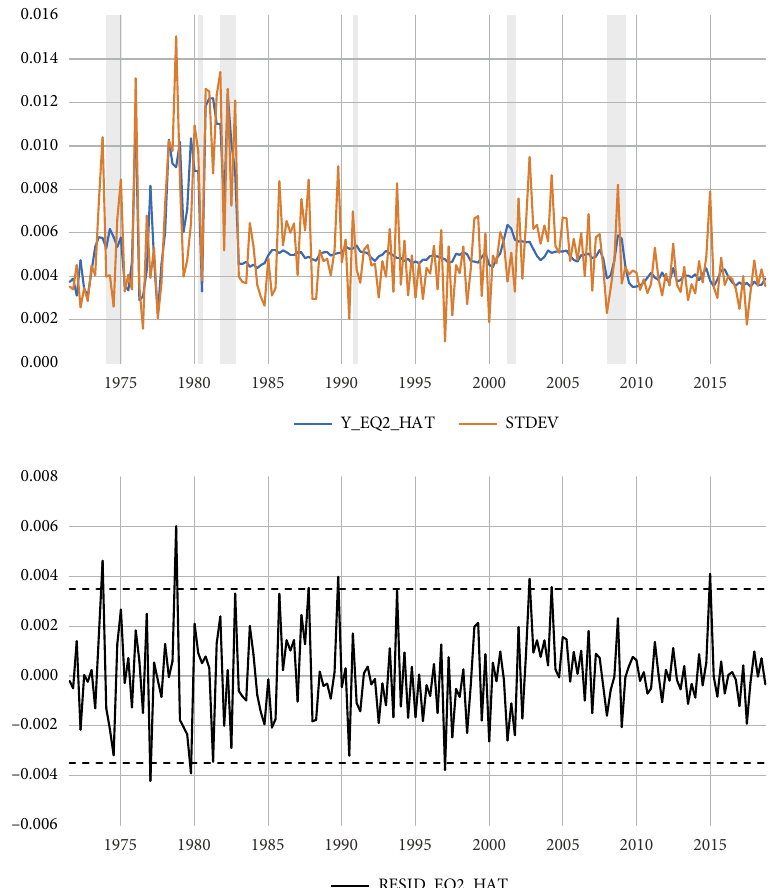
Figure 4. Multivariate estimate of STDEV via BP method. Y_EQ2_HAT stands for the estimated values of STDEV whereas RESID_EQ2_HAT shows the residuals from the equation. Shaded areas in the top panel are the recession dates. These are NBER based recession indicators for the United States from the period following the peak through the trough, +1 or 0, quarterly, not seasonally adjusted (USRECQ) (source: Federal Reserve Bank of St. Louis,